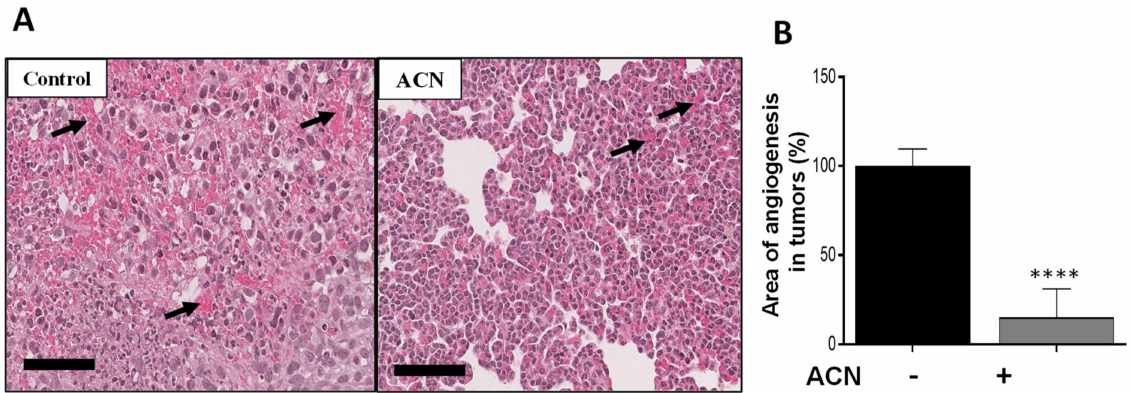
Figure 6. ACN decreased angiogenesis in tumor tissues. Photomicrographs of tumor tissues with arrows showing blood vessels ( A ). Quantification of angiogenesis areas in tumor tissues ( B ). Photomi- crographs of tumor tissues (H&E, 28X) are representative of n ≥ 10 random areas per stained section (bar represents 70 µ m). Quantification of angiogenesis area was determined with ImageJ software. Data are mean ( n ≥ 50) ± SEM. The unpaired t test with Welch’s correction was used to determine significance (**** p < 0.0001).